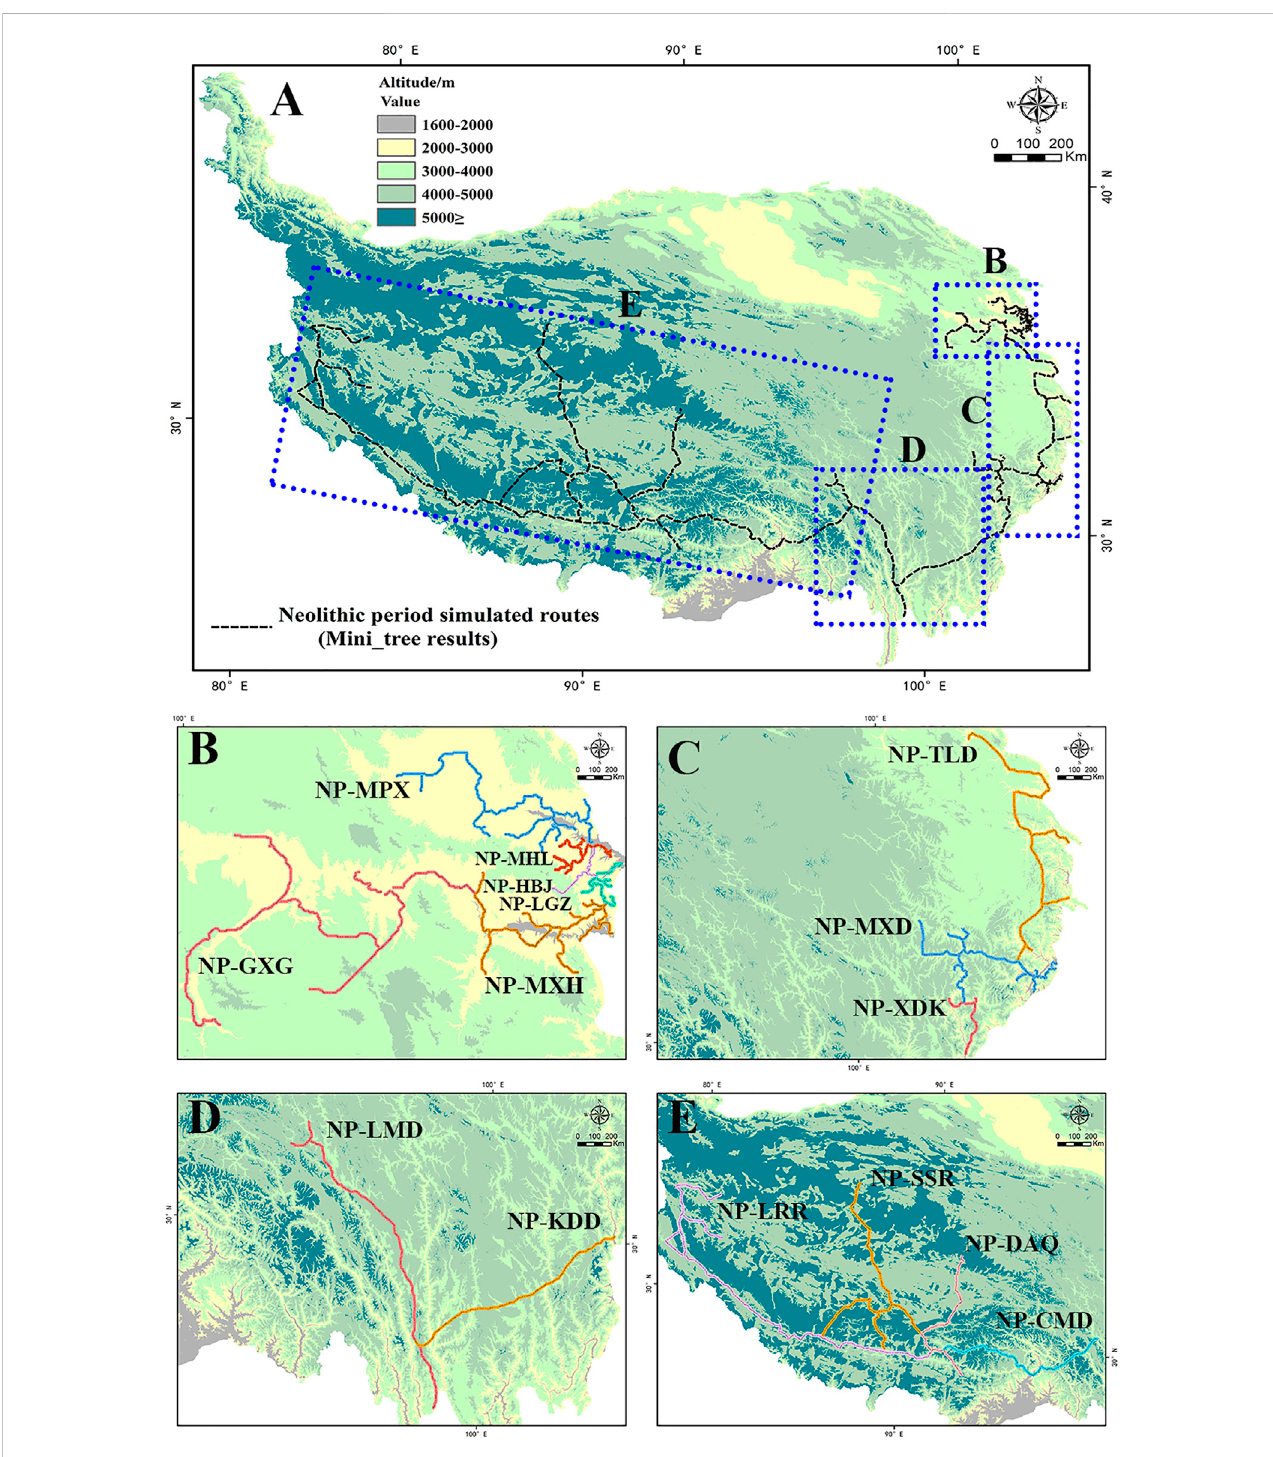
FIGURE 3 Simulated exchange routes for the neolithic period (NP). (A) overview of simulated routes and location of sub-areas; (B) northeast route area; (C) east route area; (D) southeast route area; (E) southwest route area. Individual route segments are labelled NP-XXX, with XXX referring to location